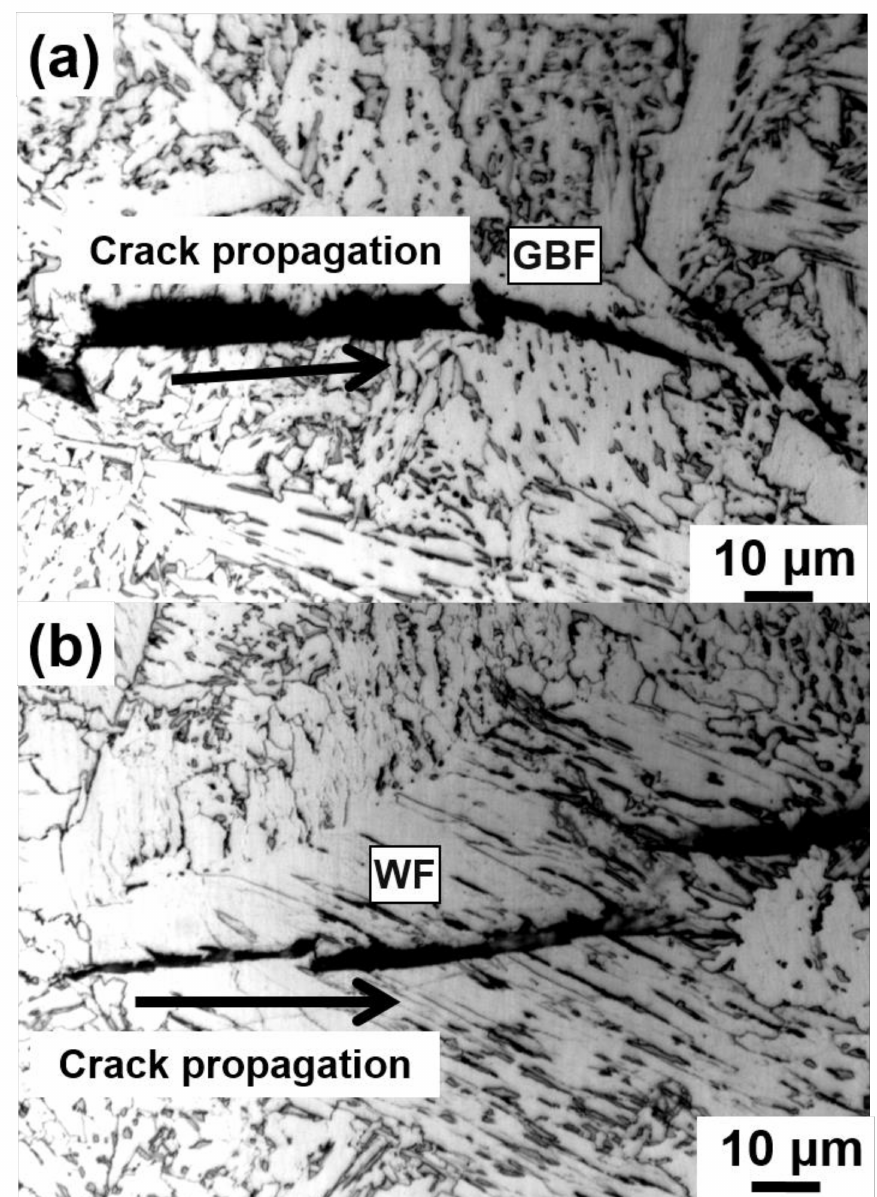
Figure 11. Propagation path for cleavage crack in the CGHAZ of the Mg-free steel ( a ) with grain boundary ferrite and ( b ) with widmanstätten